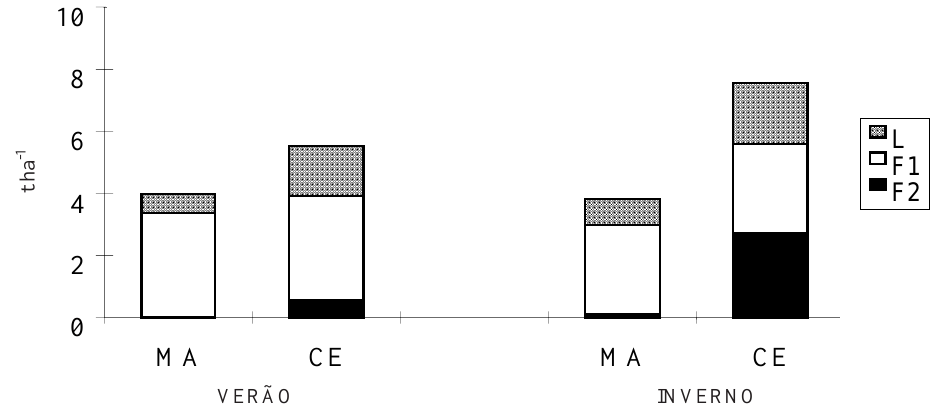
Figura 1. Comparação dos horizontes holorgânicos da Mata Alta (MA) com os da Capoeira de Extração (CE) no verão e no inverno. L: camada de folhas inteiras, F1: camada de folhas fragmentadas, F2: camada composta de quantidades iguais de folhas fragmentadas e de matéria orgânica fina (< 2 mm) entremeada por um pouco de